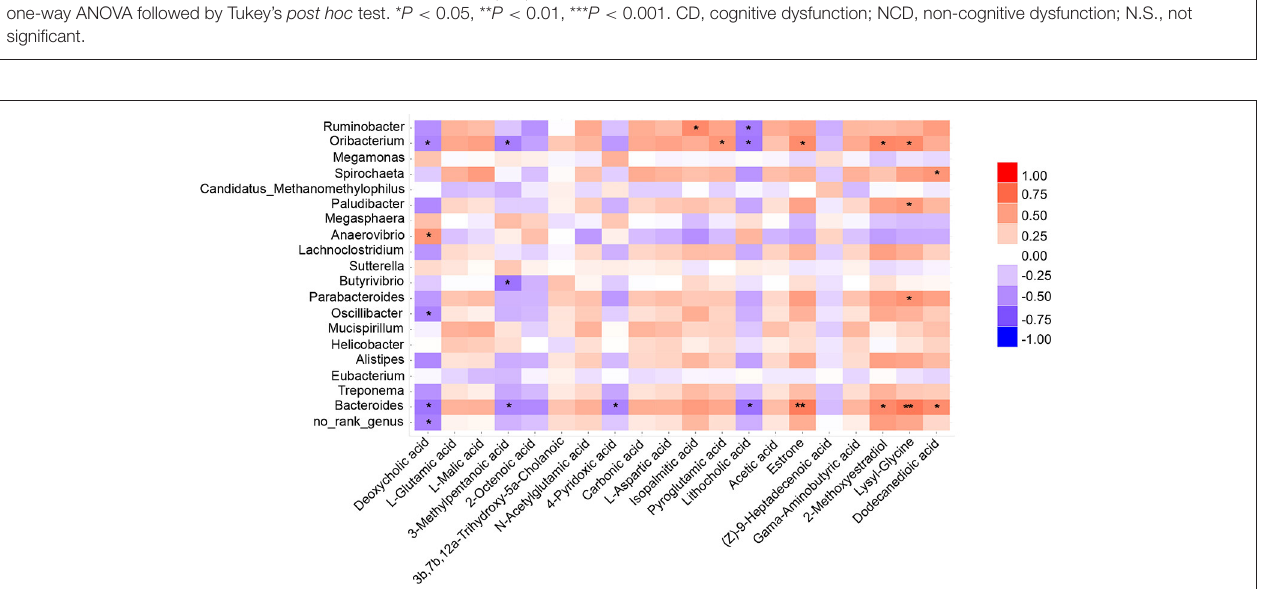
FIGURE 4 | number in a certain pathway. (E) Docosahexaenoyl serotonin [one-way ANOVA; F (2, 21) = 10.3, P < 0.001]; (F) L-Alloisoleucine [one-way ANOVA; F (2, 21) = 5.84, P = 0.009]; (G) Trp-P-1 [one-way ANOVA; F = 10.49, P < 0.001]; (H) Indoleacetaldehyde [one-way ANOVA; F = 7.259, P = 0.004]; (I) (2, 21) (2, 21) Nb-Palmitoyltryptamine [one-way ANOVA; F (2, 21) = 3.57, P = 0.05]; (J) Glutathione [one-way ANOVA; F (2, 21) = 10.81, P < 0.001]; (K) Allocholic acid [one-way ANOVA; F (2, 21) = 4.24, P = 0.028]; (L) N-Arachidonoylethanolamine [one-way ANOVA; F (2, 21) = 8.015, P = 0.018]; (M) N-Acetylornithine [one-way ANOVA; F (2, 21) = 30.86, P < 0.001]; (N) N-Undecanoylglycine [one-way ANOVA; F (2, 21) = 8.476, P = 0.002]. Data are presented as means ± SEM ( n = 8 per group) and analyzed by